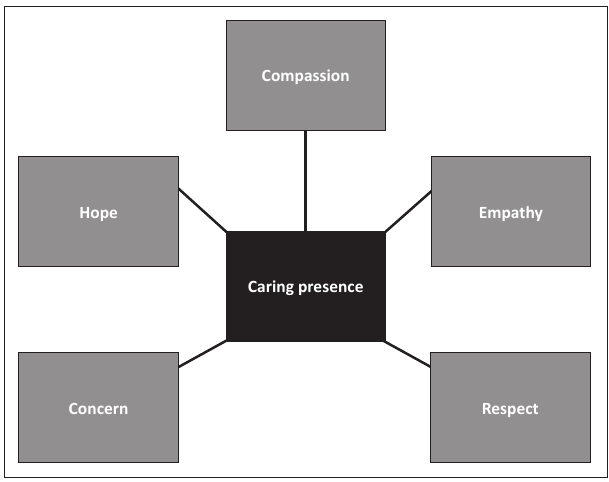
FIGURE 2: Values associated with caring presence. TABLE 2: Defining attributes and empirical referents of spiritual nursing care. Constructs of spiritual nursing care Nurses’ manifestation of actions of care in clinical practice Caring